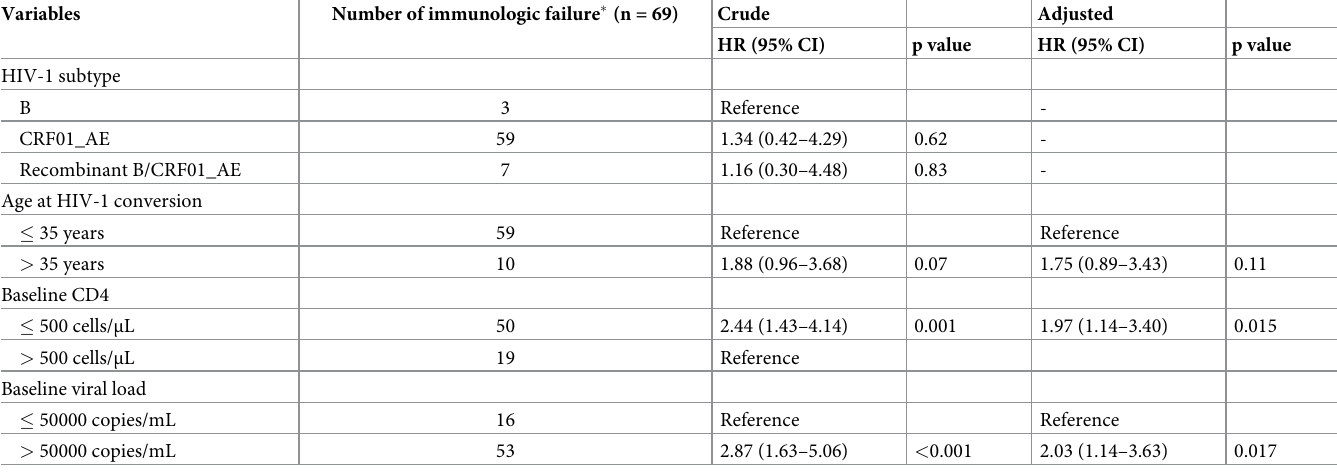
Table 2. Hazard ratios (HRs) for clinical progression from estimate date of infection (EDI) to immunologic failure.